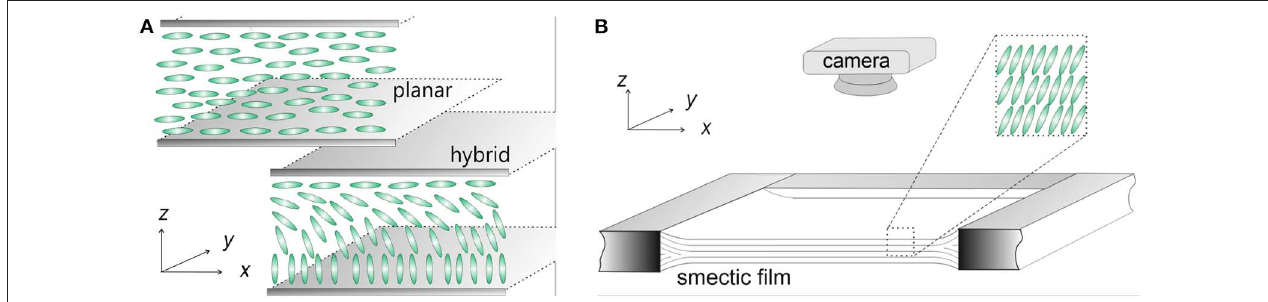
FIGURE 4 | (A) Geometry of nematic cells with planar (top) and hybrid (bottom) anchoring. The mesogens are sketched as ellipsoids. (B) Geometry of a planar freely suspended SmC film in air. The front edge of the solid film support has been omitted for visualization of the layered film